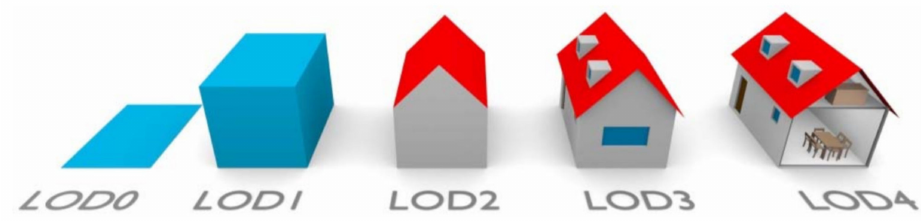
Figure 7. Subsequent levels of detail for building representation in CityGML models